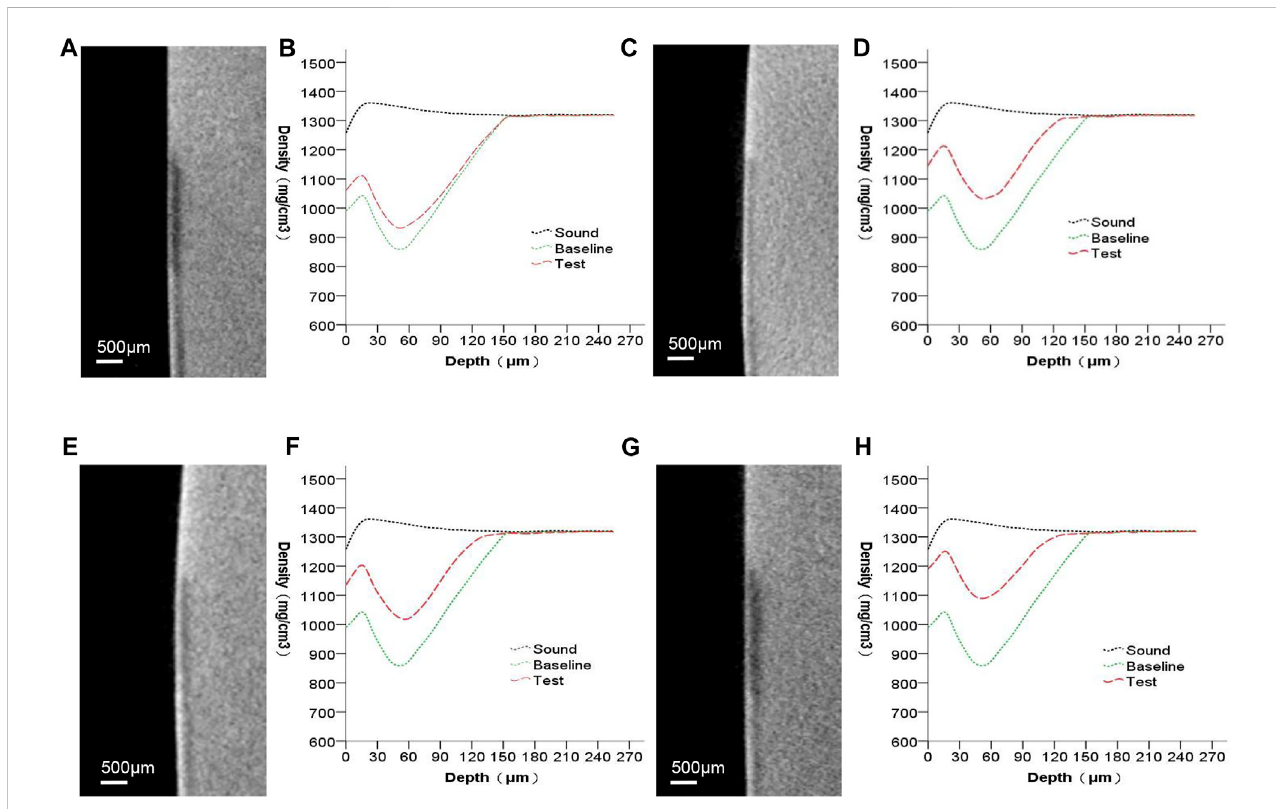
FIGURE 4 Micro-CT images of all groups. (A,B) remineralizing medium group; (C,D) studied peptide 1 group; (E,F) studied peptide 2 group; (G,H) fl uoridate group.